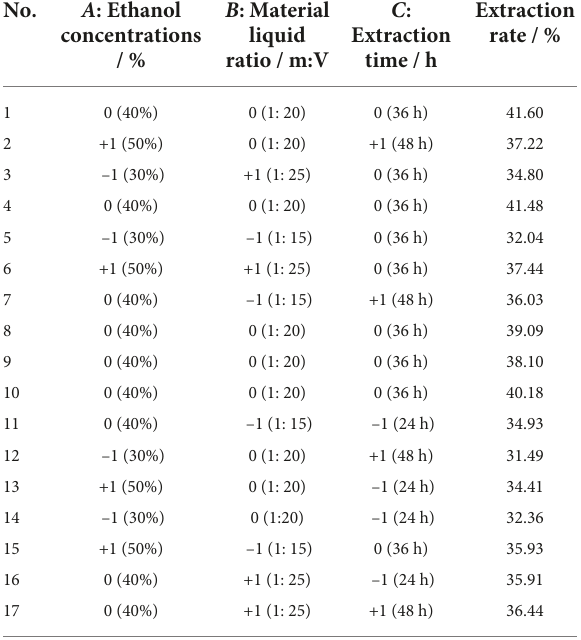
TABLE 1 Designs and results of response surface experiments.